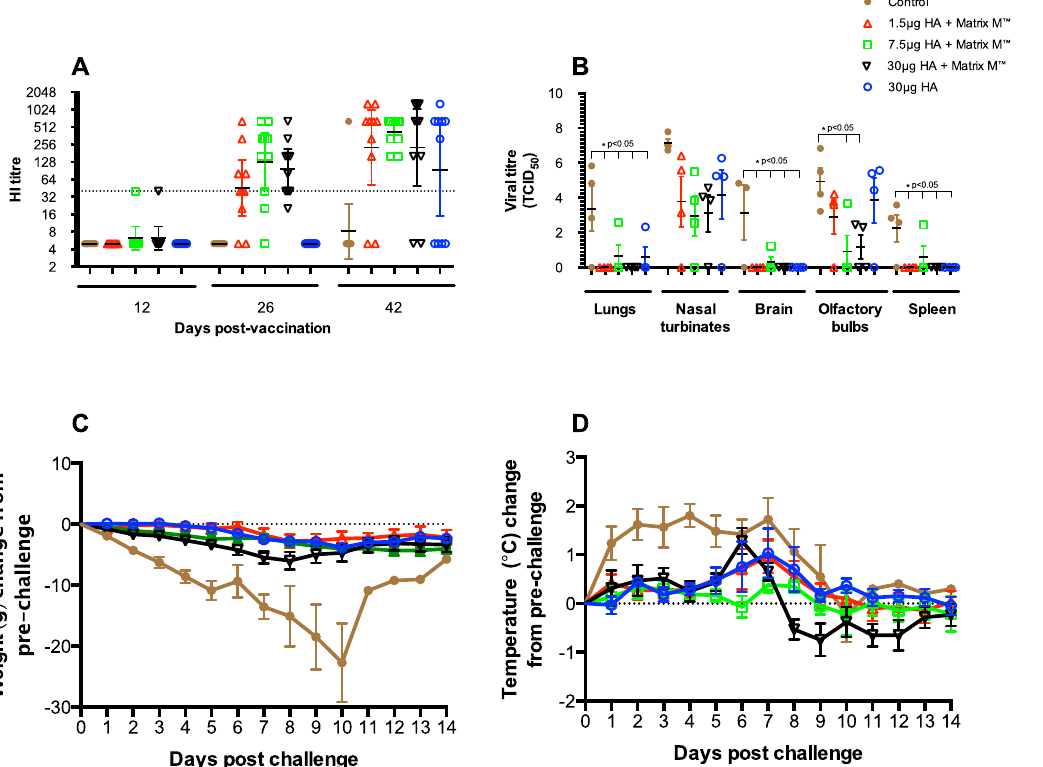
Fig 10. Protective efficacy of the H5N1 vaccine in ferrets. Ferrets were divided into five groups of 10 and were vaccinated intramuscularly with two doses (14 days apart) of virosomal vaccine alone (30 μ g HA, blue) or 1.5 (red), 7.5 (green) and 30 μ g HA (black) adjuvanted with Matrix M (50 μ g). Control ferrets (brown) received PBS. Fourteen days after the second immunization, ferrets were challenged by administering A/Vietnam/1203/2004 live virus (10 6 EID 50 in 0.4 mL PBS/BSA). (A) The serum HI antibody response 12 days after each vaccination with NIBRG-14 virosomal vaccine and fourteen days following challenge with A/Vietnam/1203/2004 virus. (B) The virus titres in the nasal washing and tissue samples after challenge with the A/Vietnam/1203/2004 virus. The limit of detection in TCID 50 assay for the ferret tissue samples was 10 1.63 TCID 50 /ml of homogenate. (C) The changes in weight and (D) temperature after challenge with A/Vietnam/1203/2004 live